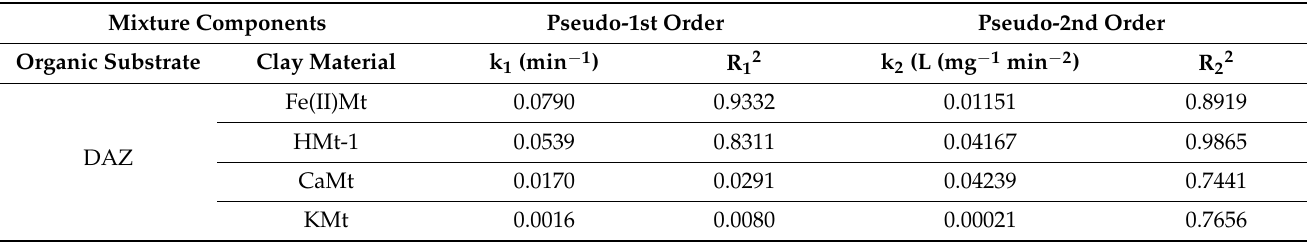
Table 2. Adsorption kinetic constants and correlation coefficients for model adsorption kinetic